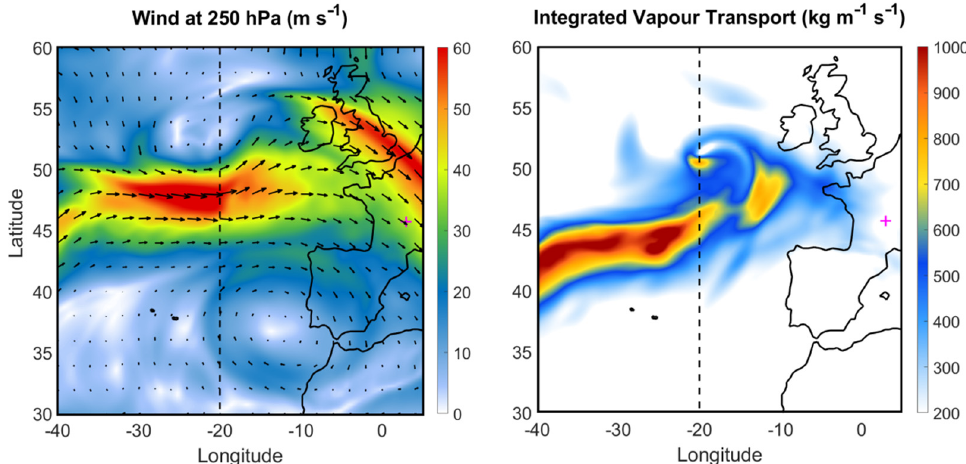
Figure 5. ECMWF ERA5 horizontal wind on the 250 hPa pressure level ( left ) and IVT maps ( right ) on 25 August 2014 at 00 UT. The dashed line represents the cross sections presented in Figure 4. The location of Clermont-Ferrand is marked by a pink cross. An animated version of this figure covering the 24–28 August period is provided as a video in the Supplementary Materials.